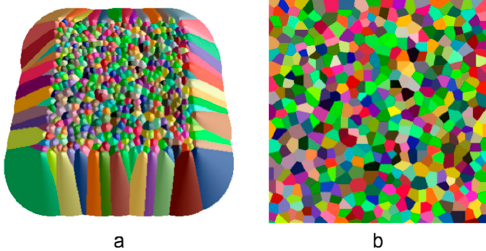
Figure 9. ( a ) Circular cone in 3D space; ( b ) results after rendering.